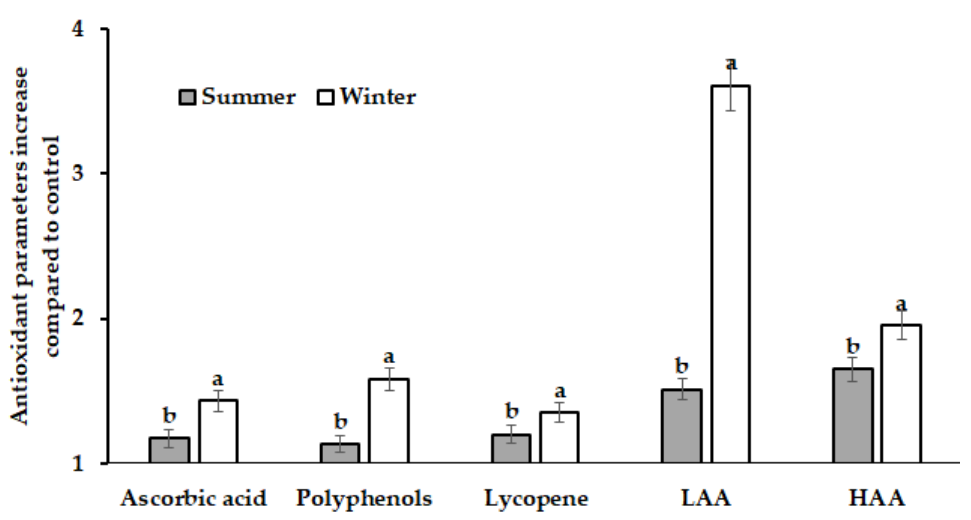
Figure 2. Protein hydrolysate (PH)’s effect on changes of the ascorbic acid, polyphenols, lycopene content, and LAA and HAA activities in summer and winter tomato fruits. For each parameter, values with different letters differ statistically according to Duncan test at p < 0.05.